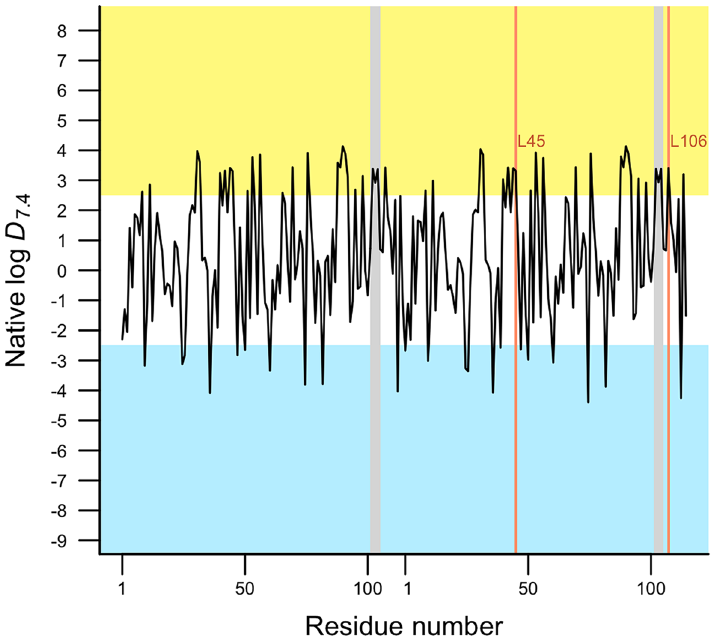
Figure 7. Residue-level lipophilicity expressed as the distribution coefficient of amino acids to pH = 7.4 (log D 7.4 ) for the native dimer of Nsp9 protein. Highly hydrophobic and hydrophilic regions are shown in yellow and blue sections, respectively. GxxxG motifs are represented in grey rectangles and residues Leu45 and Leu106 in orange